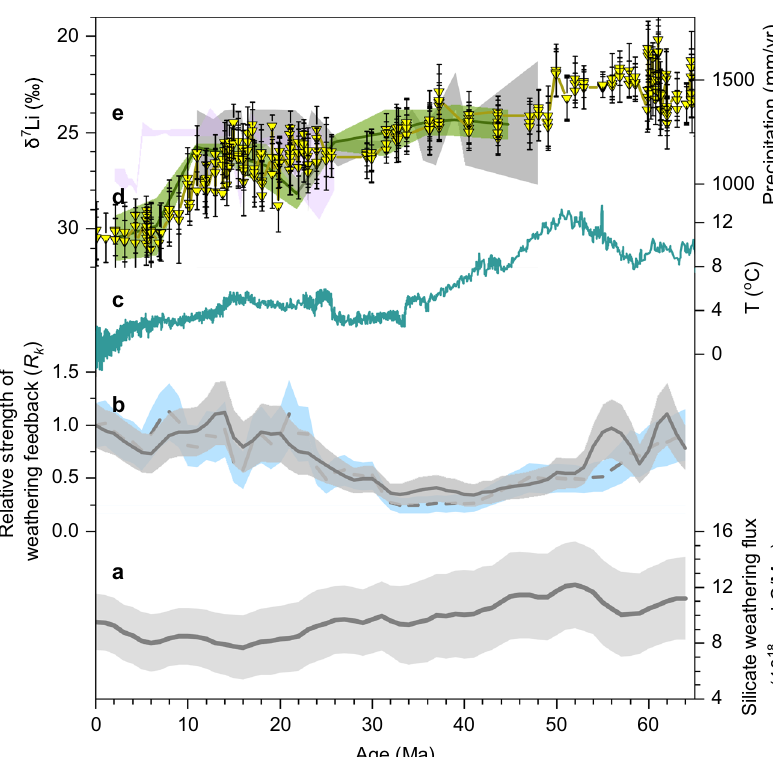
Fig. 5 Geological δ 7 Li records, climate and weathering fl ux. ( a ) Silicate weathering fl ux (grey solid line) 4 . ( b ) Relative strength of weathering feedback, with dark and light blue shadings indicating low and high atmospheric CO 2 scenarios 4 , respectively. ( c ) Deep ocean temperature (dark green) 73 . ( d ) Seawater δ 7 Li (yellow) evolution during the Cenozoic 6 . ( e ) Continental mean annual precipitation from the Paci fi c (green) and Atlantic (grey and light purple) sides of Eurasia 75 . During the Cenozoic cooling, increasing δ 7 Li coincides with decreasing precipitation recorded at the two sides of Eurasia ( e ) and are likely coupled with a stable or decreased silicate weathering rate ( a ). Shadings in a and b indicate 1 σ uncertainty, and in e show mean annual range of